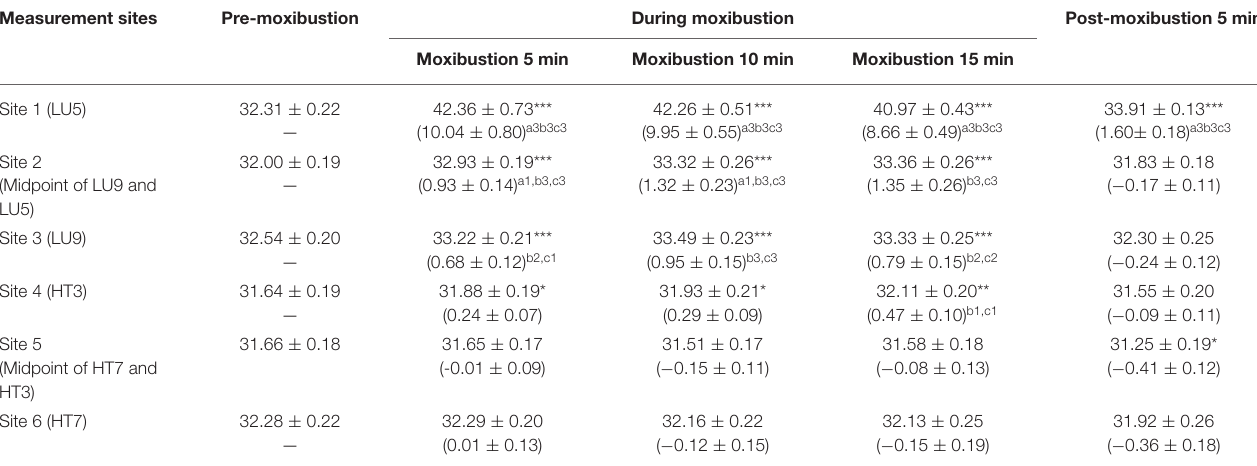
TABLE 3 | Temperature and its corresponding change magnitude in measurement Sites of both meridians in the Lung intervention group (mean ± SEM, ◦